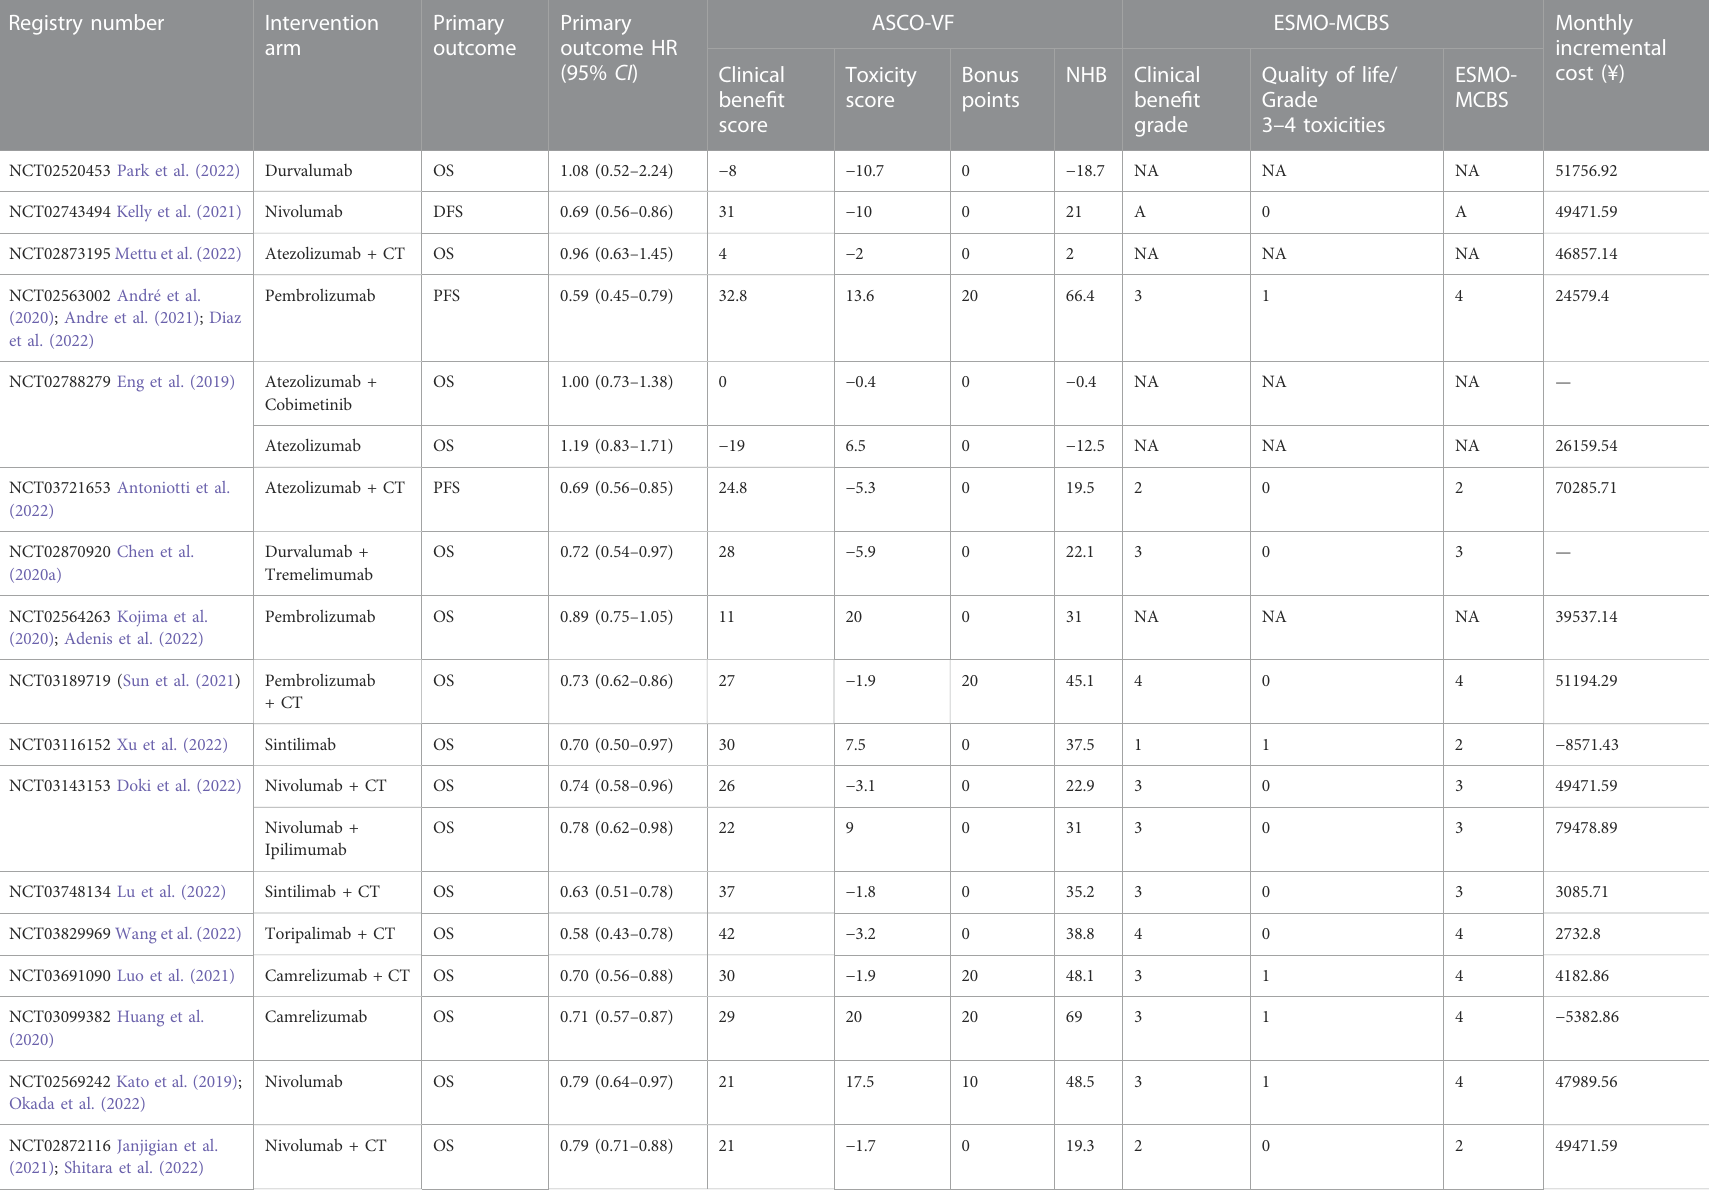
TABLE 2 Clinical bene fi t according to ASCO-VF and